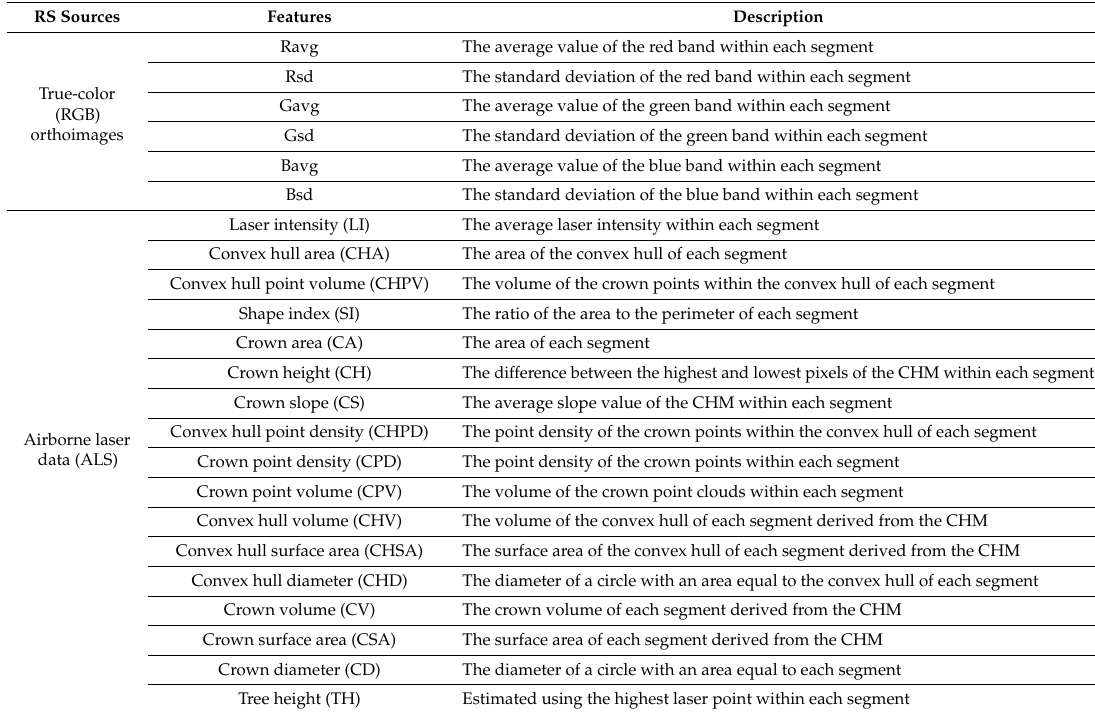
Table 2. Features and variables extracted from the airborne laser (ALS) data and orthoimages for all